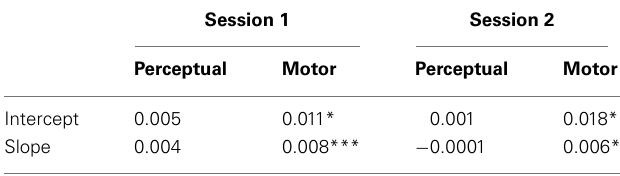
sequence learning task analyzed via linear regression